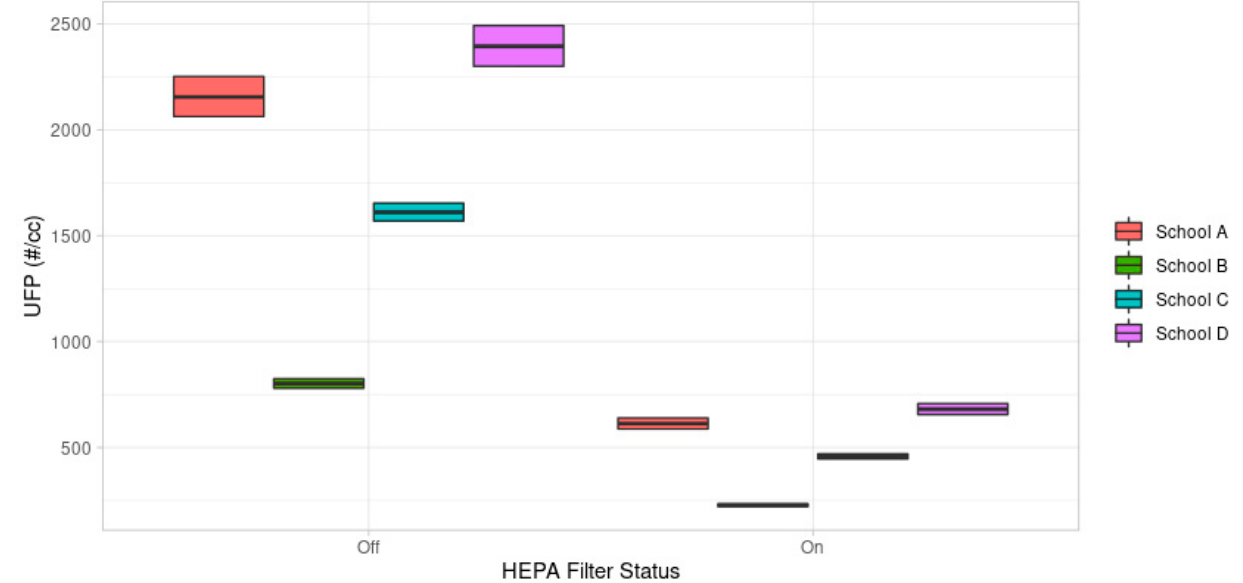
Figure 6. Prediction of indoor concentrations with and without a portable HEPA filter deployed in the classroom. The middle bar represents the mean, and the top and bottom bars represent the upper and lower 95% confidence interval. We assumed an outdoor concentration of 5000 #/cc to predict the indoor concentrations. School E was not included in this model due to multiple 0 values for the indoor air quality measurement.